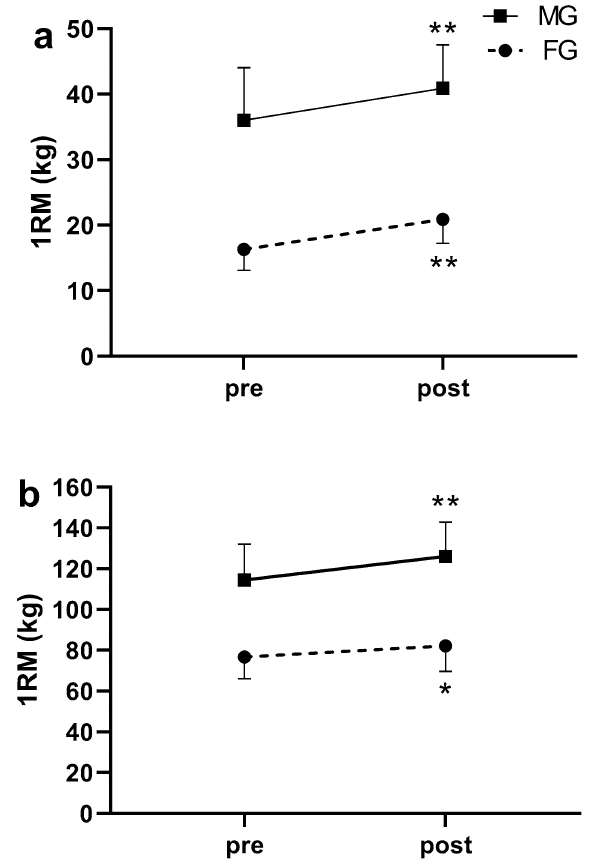
Figure 2. Pre-to-post changes in biceps curl ( a ) and parallel squat ( b ) one-repetition maximum (1RM) for males (MG) and females (FG). Graphical representations were generated using GraphPad Prism software version 9.0.2 (https:// www. graph pad. com/ scien tific- softw are/ prism/). *Significantly greater than pre-training (p < 0.05). **Significantly greater than pre-training (p < 0.01).